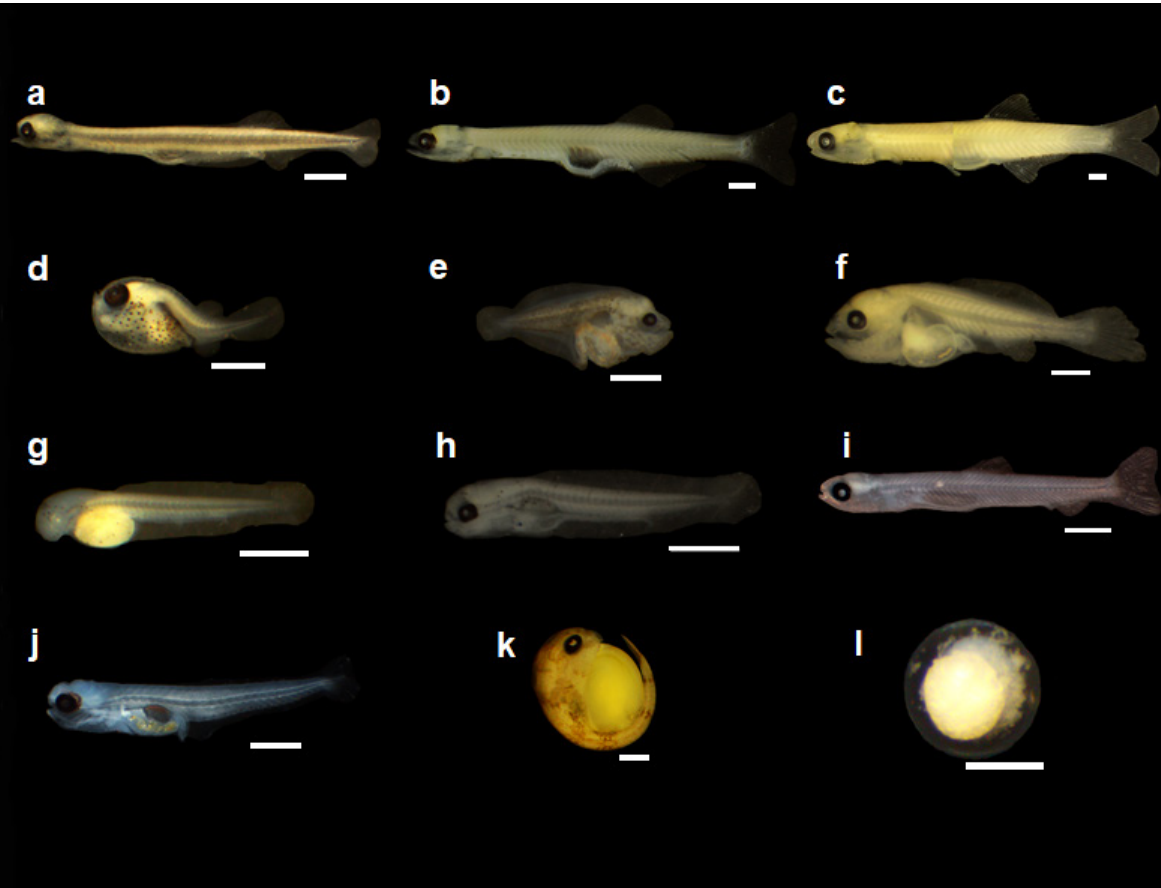
Figure 2. Images of some ichthyoplankton organisms collected during samplings from September 2017 to August 2018 at Lake Juá, at the mouth of the Tapajós River, state of Pará, Brazil. a) Engraulidae; b) Anchoviella juruassanga ; c) Anchoviella jamesi ; d) Colomesus asellus ; e) Hypoclinemus mentalis ; f) Plagioscion squamosissimus ; g) Characiformes yolk-sac stage; h) Psectrogaster amazonica ; i) Hemiodus immaculatus ; j) Microphilypnus tapajosensis ; k) egg with visualization of the embryo of Loricariichthys acutus in the final stage (guarding species) and l) pelagic egg in the initial cleavage of non-guarding specie. Bars = 1